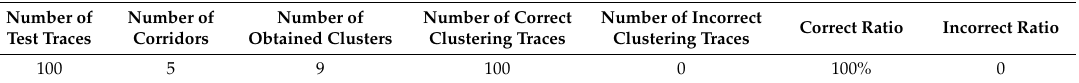
Table 2. Road segment clustering result using C-neighborhood DBSCAN